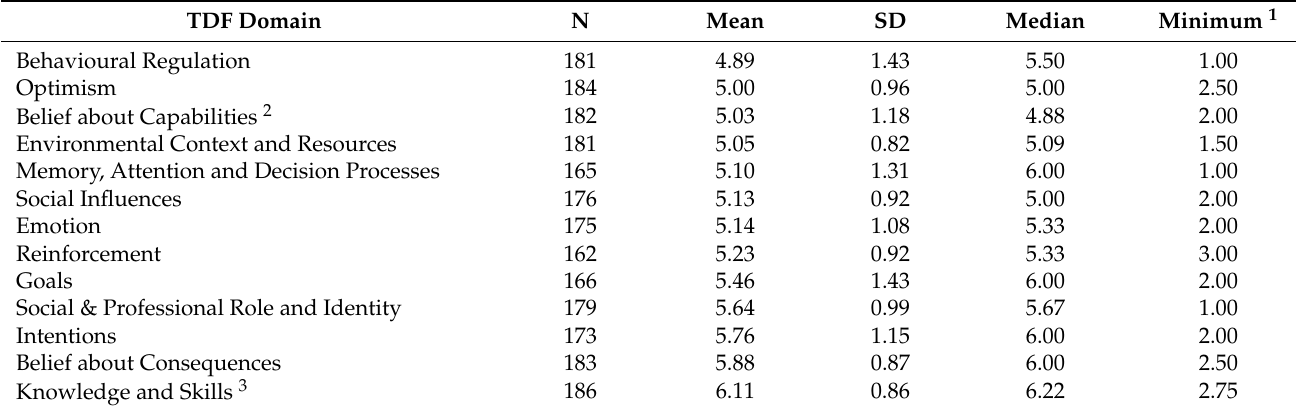
Table 3. CMO staff members mean and median scores for TDF domains.